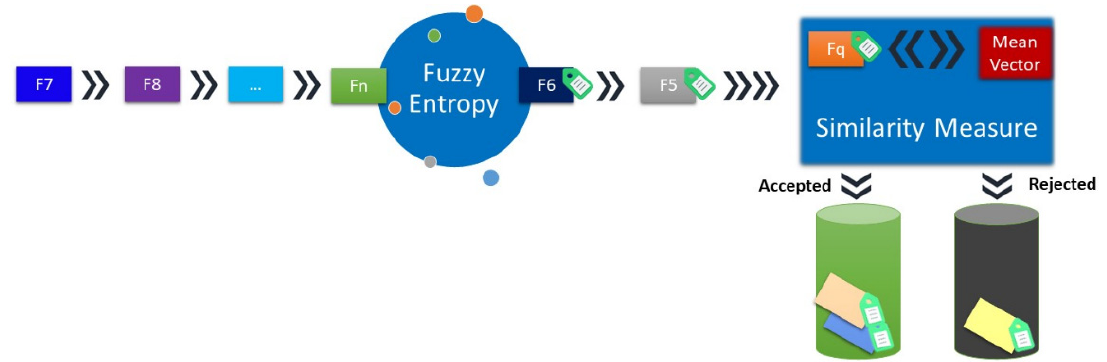
Figure 6. Flow diagram for Luca-measure fuzzy entropy (LFE) and Lukasiewicz similarity measure (LS)–based feature selection.